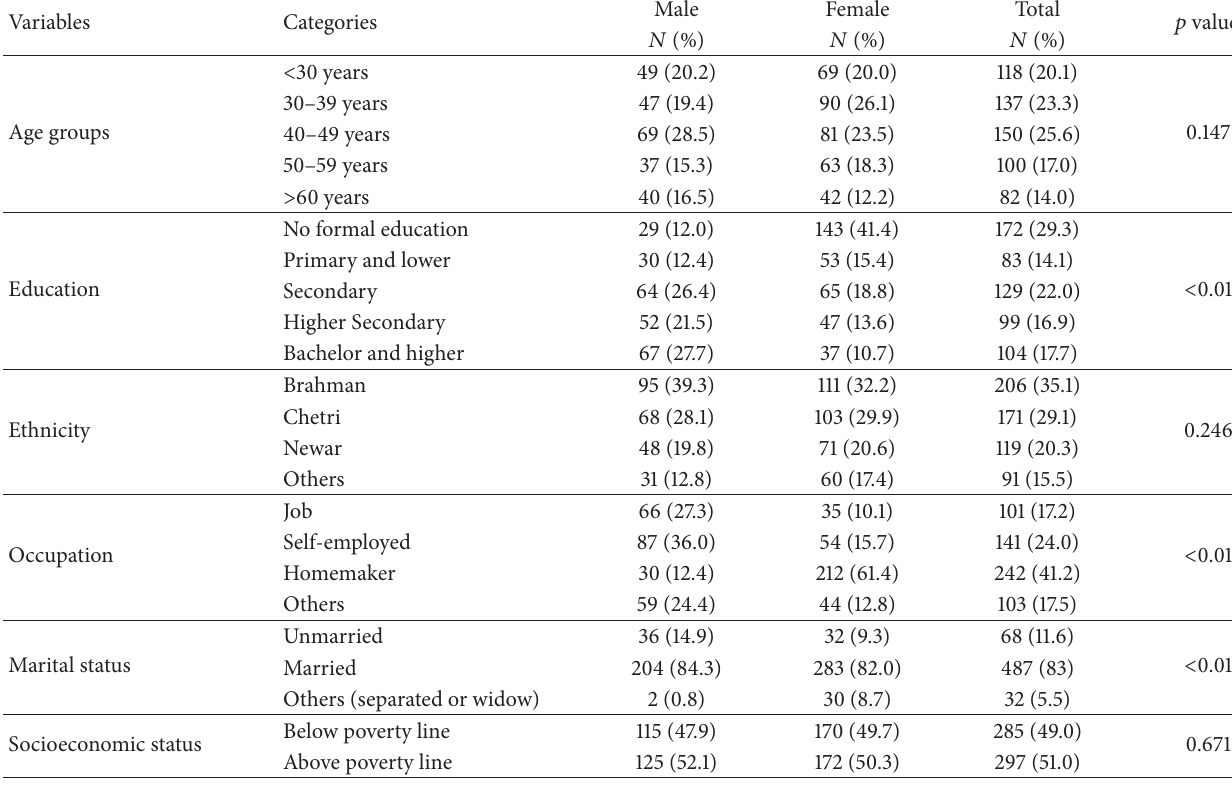
Table 1: Distribution of sociodemographic characteristics by